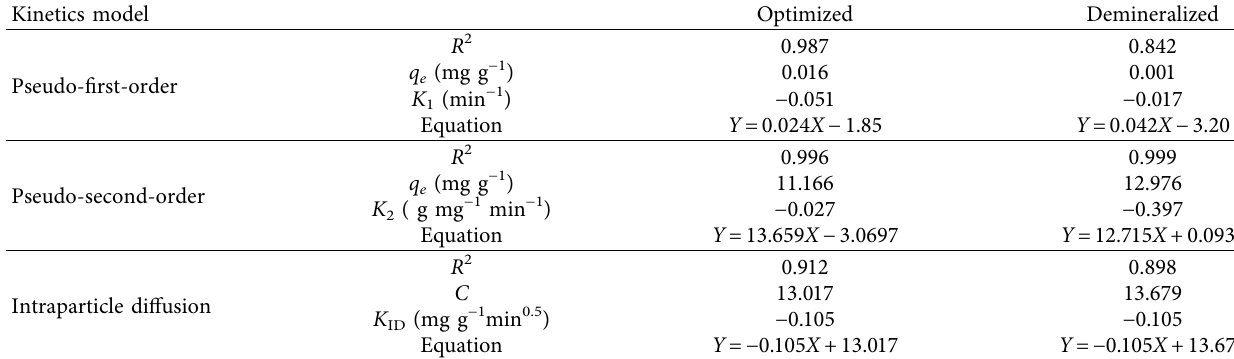
Table 6: Adsorption kinetics and intraparticle